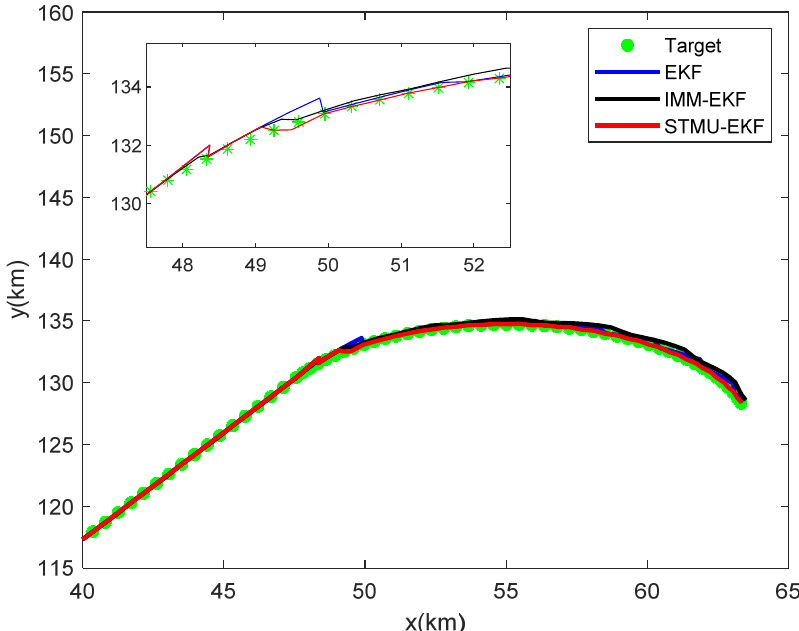
Figure 7. The target tracking trace in the multi-sensor collaborative management model.